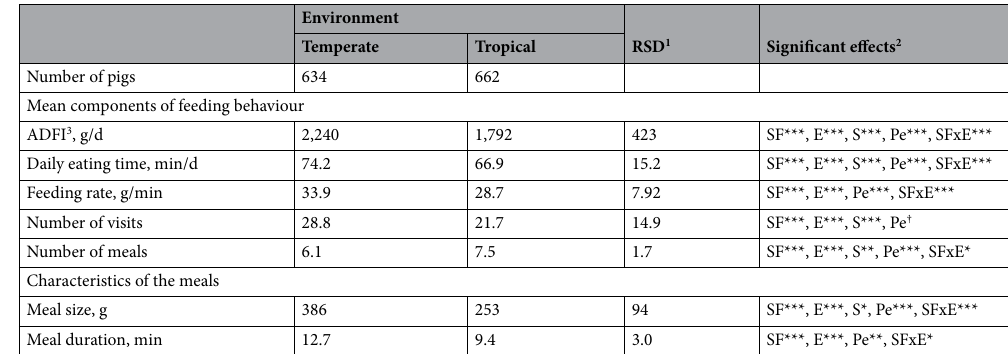
Table 1. Least squares means effect of production environment, sire family and sex on feeding behaviour traits. 1 Residual Standard Deviation. 2 From an analysis of variance with a linear model including the effects of Sire Family (SF), Environment (E), Sex (S), Period of feed intake recording (Pe) and their interactions as fixed effect. Batch within environment was significant for all traits and is not reported in the table. Statistical significance: ***P < 0.001, **P < 0.01, *P < 0.05, † P ≤ 0.10. 3 ADFI = Average Daily Feed